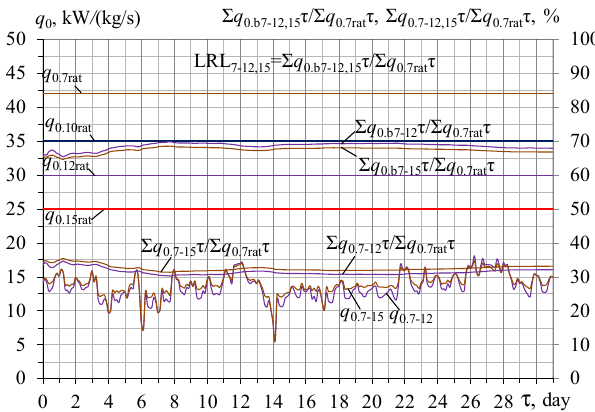
Figure 14. Actual values of refrigeration capacities q 0.7–12 and q 0.7–15 for subcooling the air from 12 and 15 to 7 ° С , corresponding to relative values of averaged summarized refrigeration energy consumed in unregulated ranges ∑ ( q 0.7–12 τ )/ ∑ ( q 0.7rat τ ) and ∑ ( q 0.7–15 τ )/ ∑ ( q 0.7rat τ ) and in regulated ranges as LRL = ∑ ( q 0.b7–12 τ )/ ∑ ( q 0.7rat τ ) and LRL = ∑ ( q 0.b7–15 τ )/ ∑ ( q 0.7rat τ ) for precooling the ambient air to the temperatures 12 and 15 ° С as threshold values: q 0.b7–12/15 = q 0.7rat − q 0.12/15 ; q 0.7–12/15 = q 0.7 − q 0.12/15 .